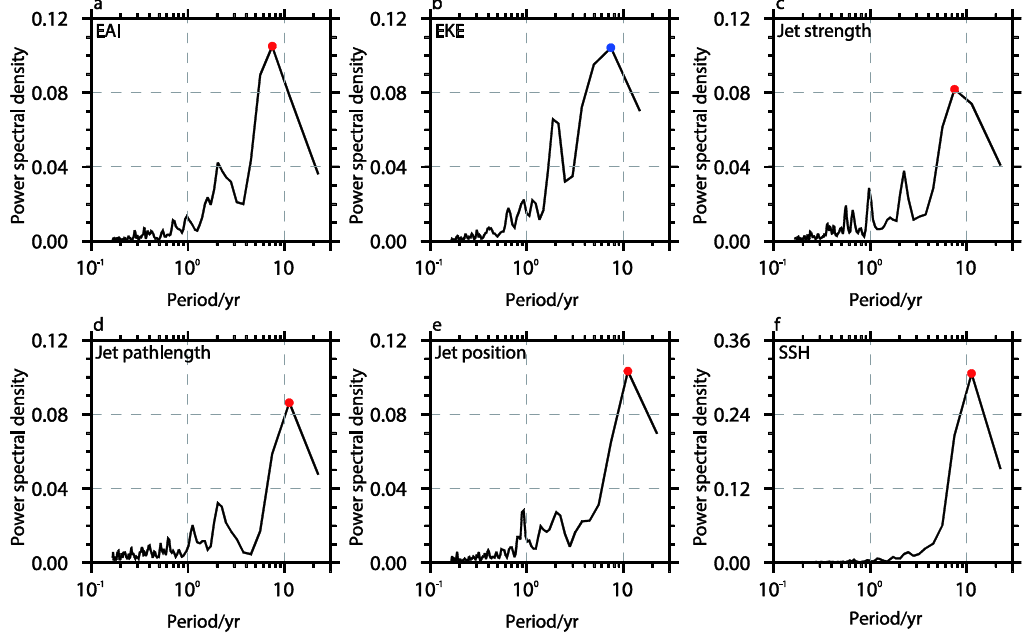
Figure 2. Power spectra of the normalized ( a ) EAI, ( b ) EKE, ( c ) jet strength, ( d ) jet pathlength, ( e ) jet position, and ( f ) SSH indices of KE. Red (blue) dots indicate the spectral peak significant (insignificant) at the 95% confidence level.